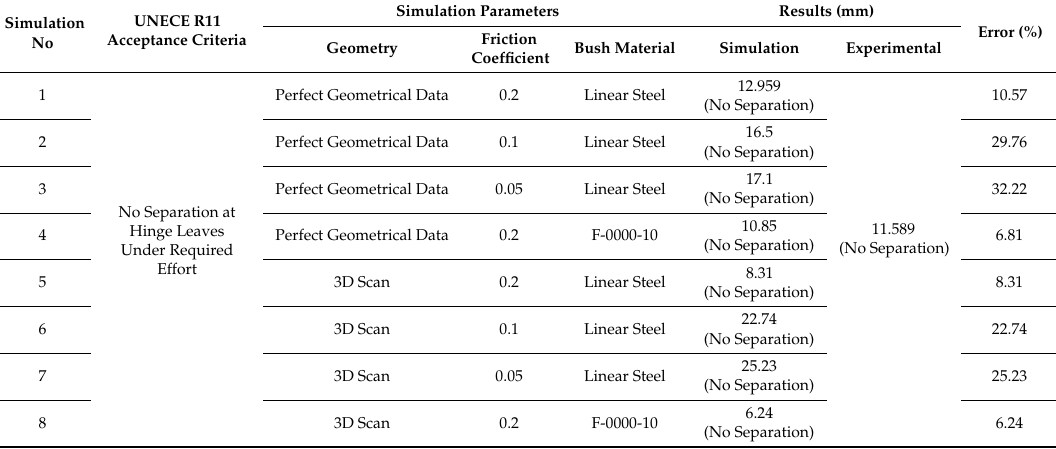
Figure 21. Direction of Z force-displacement curves according to simulation parameters. Table 2. Error values of force-displacement curves according to experimental